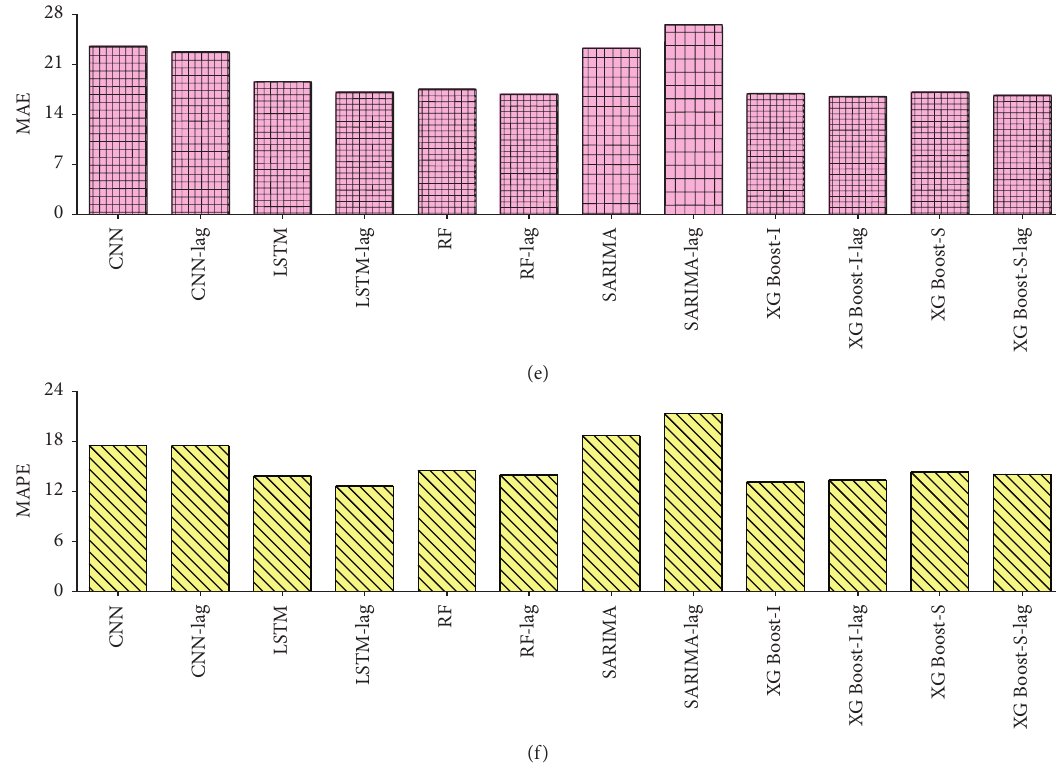
Figure 15: Comparison of three errors in different methods of up-direction and down-direction.